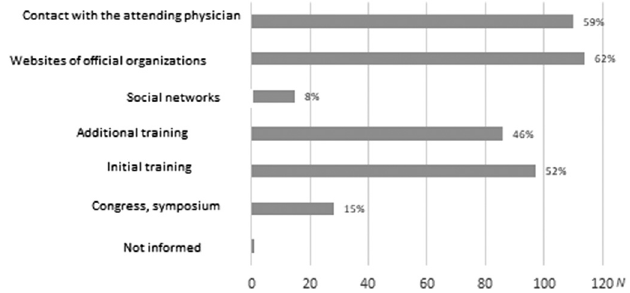
Fig. 6. Guidelines used for the management of antithrombotic patients (